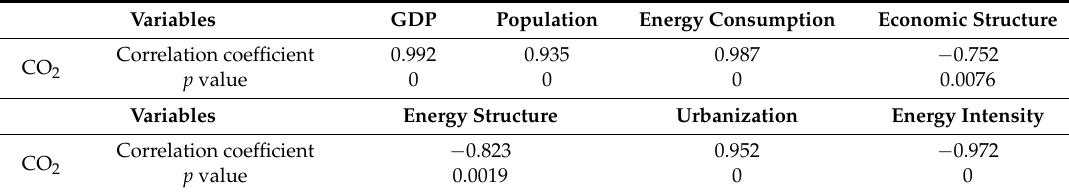
Table 1. Correlation analysis between CO 2 and each